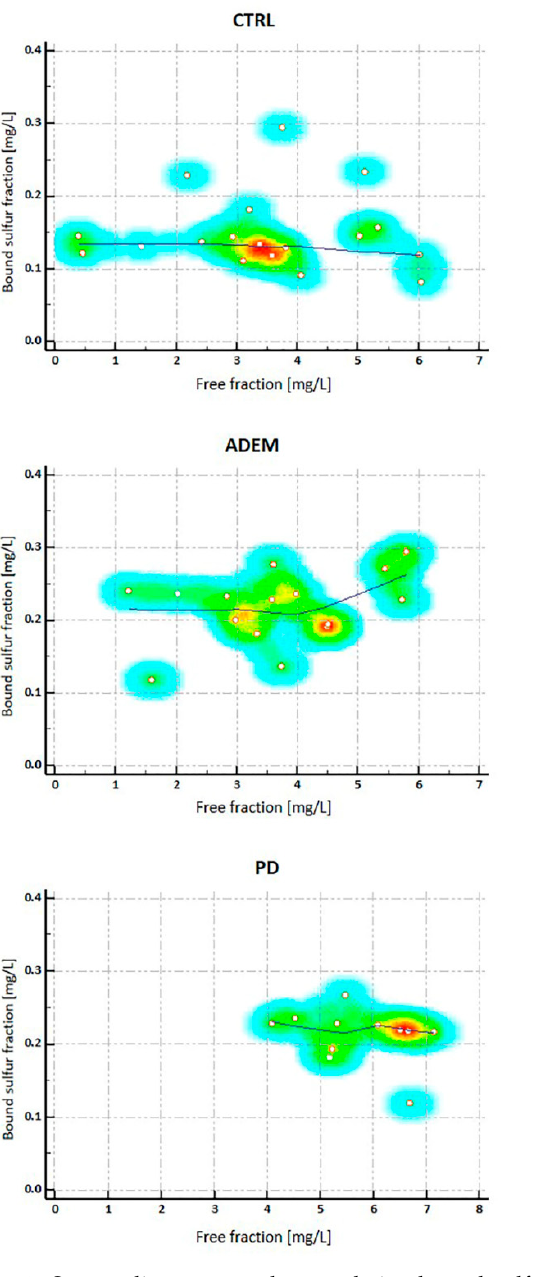
Figure 4. Scatter diagrams on the correlation bound sulfur/free H 2 S in all the clinical groups analyzed. All the data were analyzed with MedCalc statistical software; Pearson’s analytical test have been applied to compare bound sulfur levels with free H 2 S measurements. Free H 2 S and bound sulfur variables define the horizontal axis and the vertical axis respectively. No correlation between the two variables was found for CTRL, ALS, ADEM, AD, and PD. In the last box, a significant inverse correlation has been shown for the MS group (coefficient correlation r = − 0.6478; p < 0.0001). CTRL = control; ALS = Amyotrophic lateral sclerosis; ADEM = Acute Disseminated Encephalomyelitis; AD = Alzheimer’s disease; PD = Parkinson’s disease; MS = Multiple